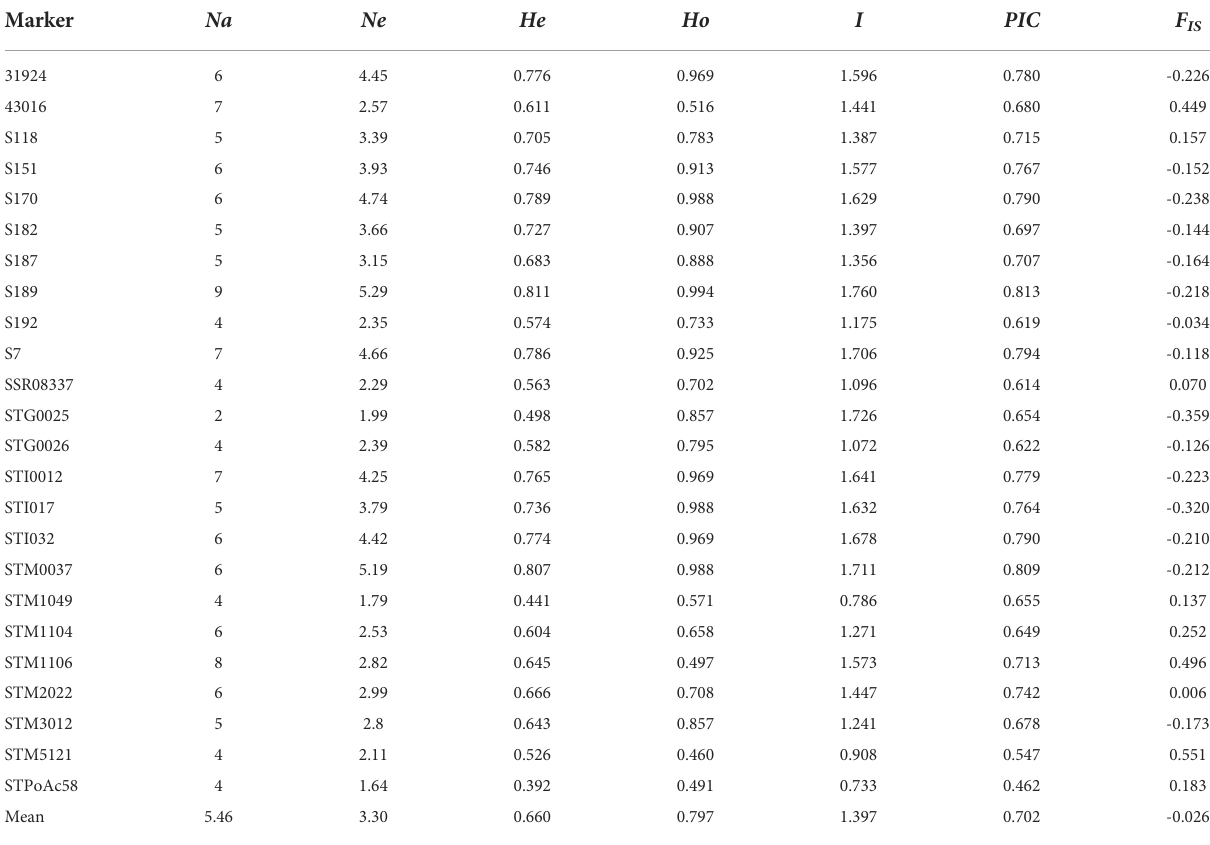
TABLE 2 Diversity information parameters of 149 cultivated potato genotypes using 24 SSR